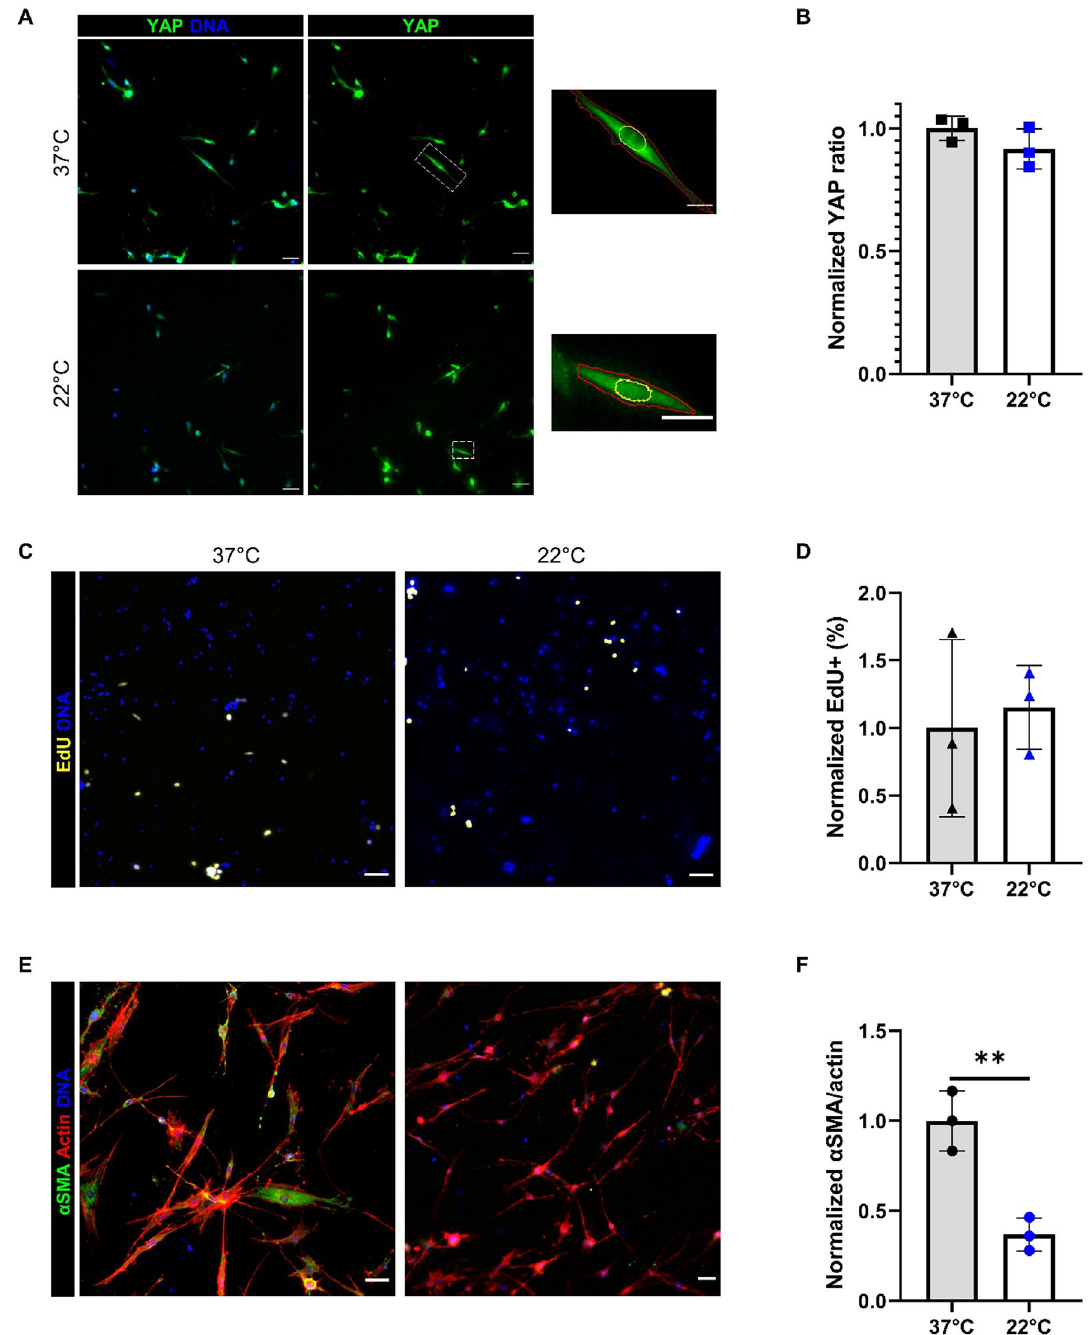
Figure 5. Effect of fibril size on FAP behavior. ( A ) YAP immunofluorescence of FAPs on 3 mg/ml telocollagen gels polymerized at 37 and 22 °C. Yellow outlines indicate nuclei and red outlines indicate cytoplasm on insets. ( B ) Quantification of YAP signal intensity to find nuclear to cytoplasmic ratio of YAP. ( C, D ) EdU signal and quantification of percent proliferating cells after 24 h EdU treatment. ( E ) αSMA signaling in FAPs after 7 days. Scales bars set to 50 μm. ( F ) Quantification of αSMA and actin area ratio. ** P < 0.01. Data normalized to 37 °C. Scales bars set to 50 µm; insets set to 20 µm. N = 1 mouse and n = 3 independent